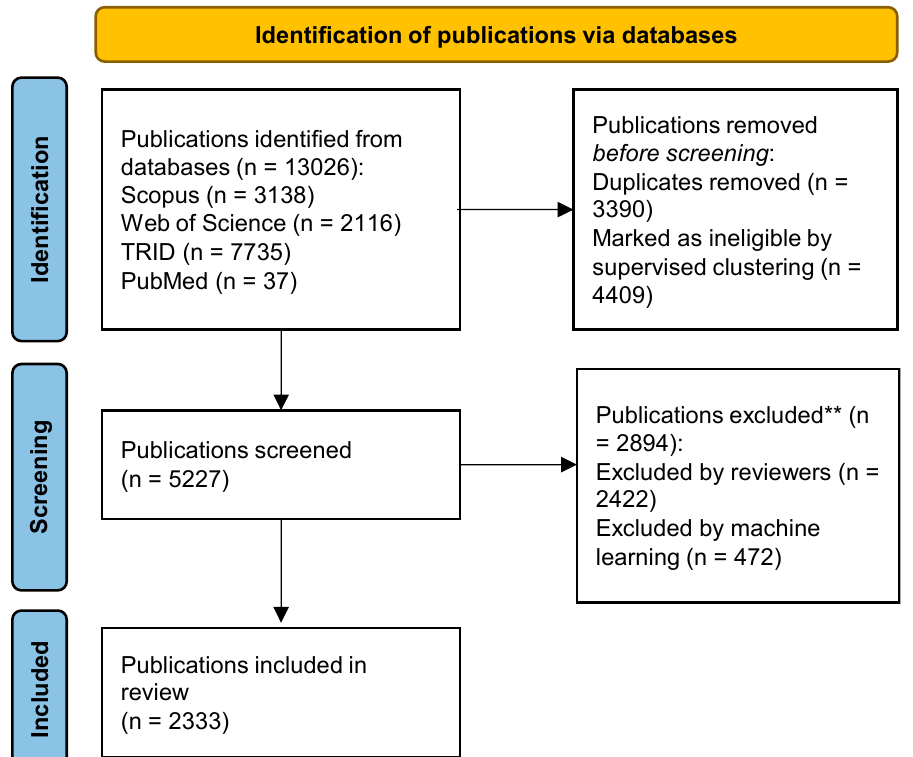
Figure 2. PRISMA Flow Diagram for Congestion Pricing Bibliometric Analysis*. * Modified for a bibliometric analysis with no screening of full-text publications. ** See Section 2.2 for description of inclusion and exclusion criteria.